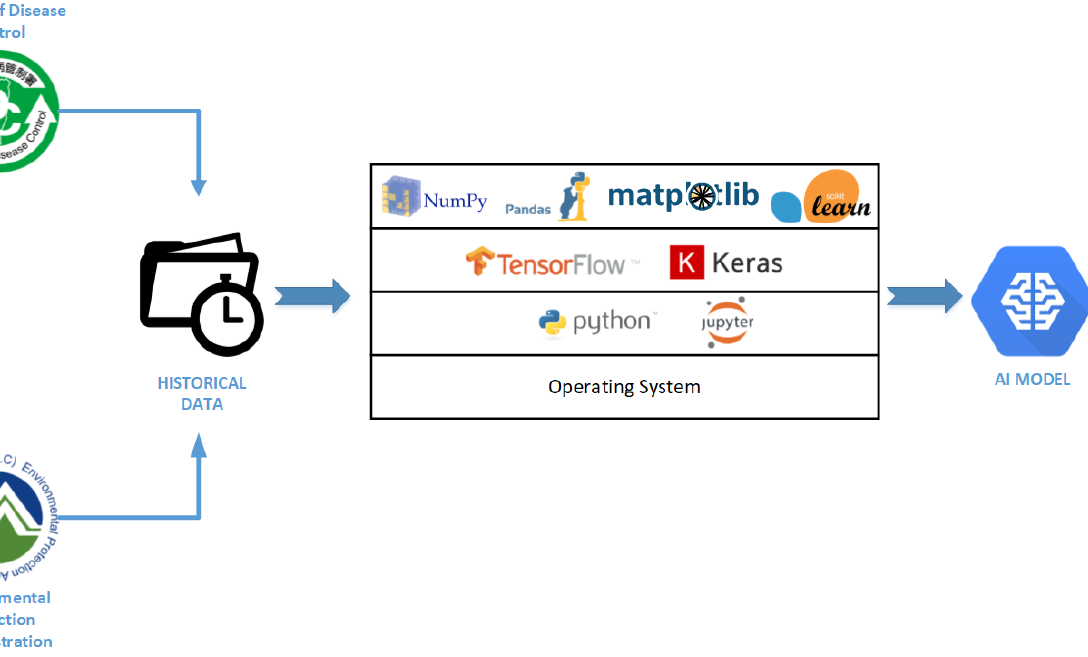
Figure 1. System